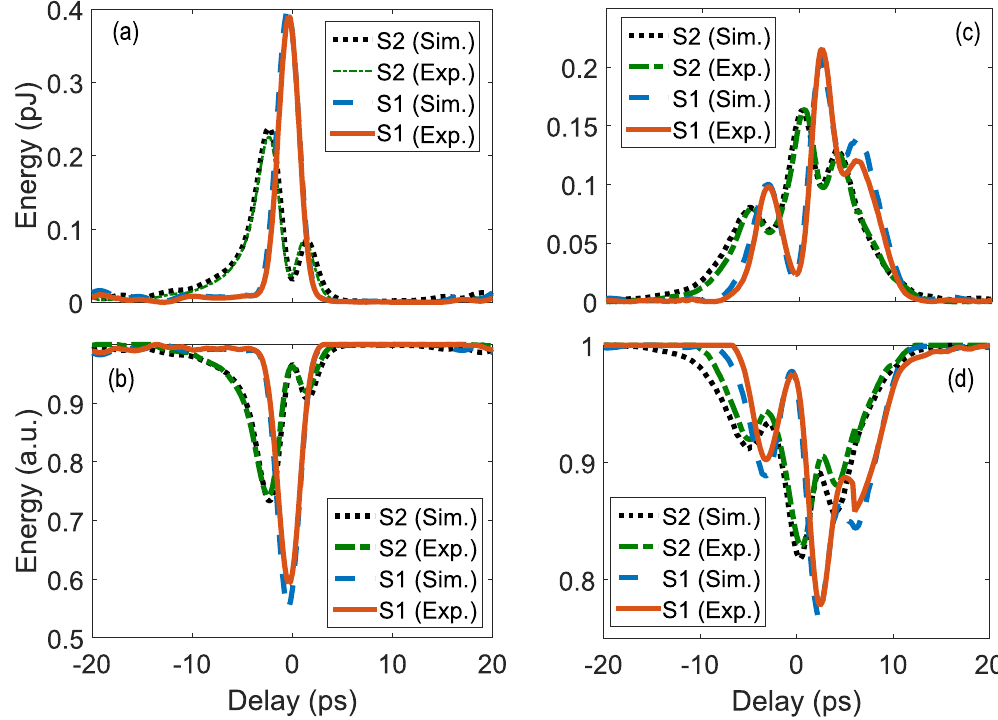
Figure 7. Low conversion regime measurement results. ( a ) and ( b ) show the measured and simulated SF and depleted-signal powers, respectively, for the two signals in Fig. 5 while they are relatively delayed from Pump 1 in Fig. 5. ( c ) and ( d ) plot the same but for Pump